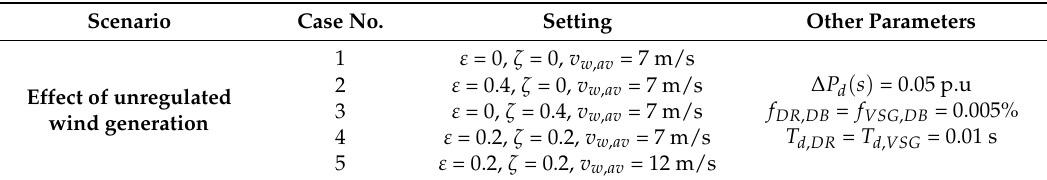
Figure 10. Effect of DR and VSG control on various system parameters under load disturbance in the presence of unregulated wind generation: ( a ) system frequency response; ( b ) change in turbine power (p.u); ( c ) change in DR power (p.u); ( d ) change in VSG power (p.u); ( e ) change in wind power (p.u); and ( f ) change in turbine, DR and VSG power (p.u) for selected cases. Table 5. DR and VSG control in the presence of unregulated wind generation: simulation scenarios and parameter